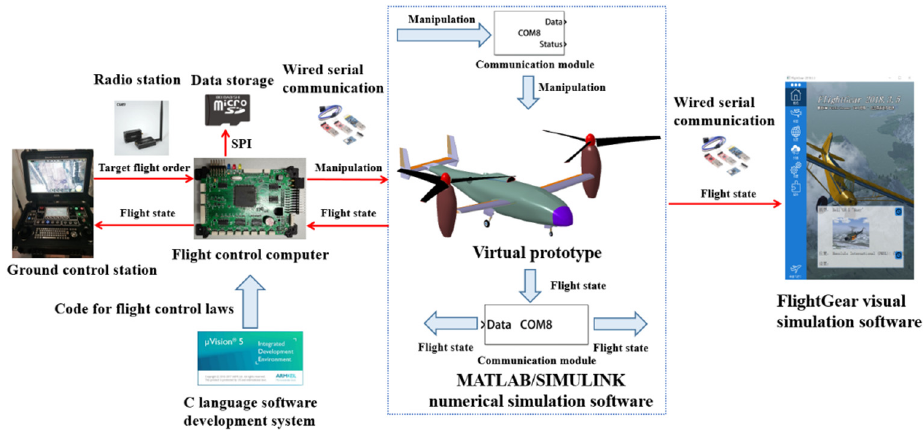
Figure 5. Composition diagram of the HIL simulation system of the tilt ‐ rotor UAV.